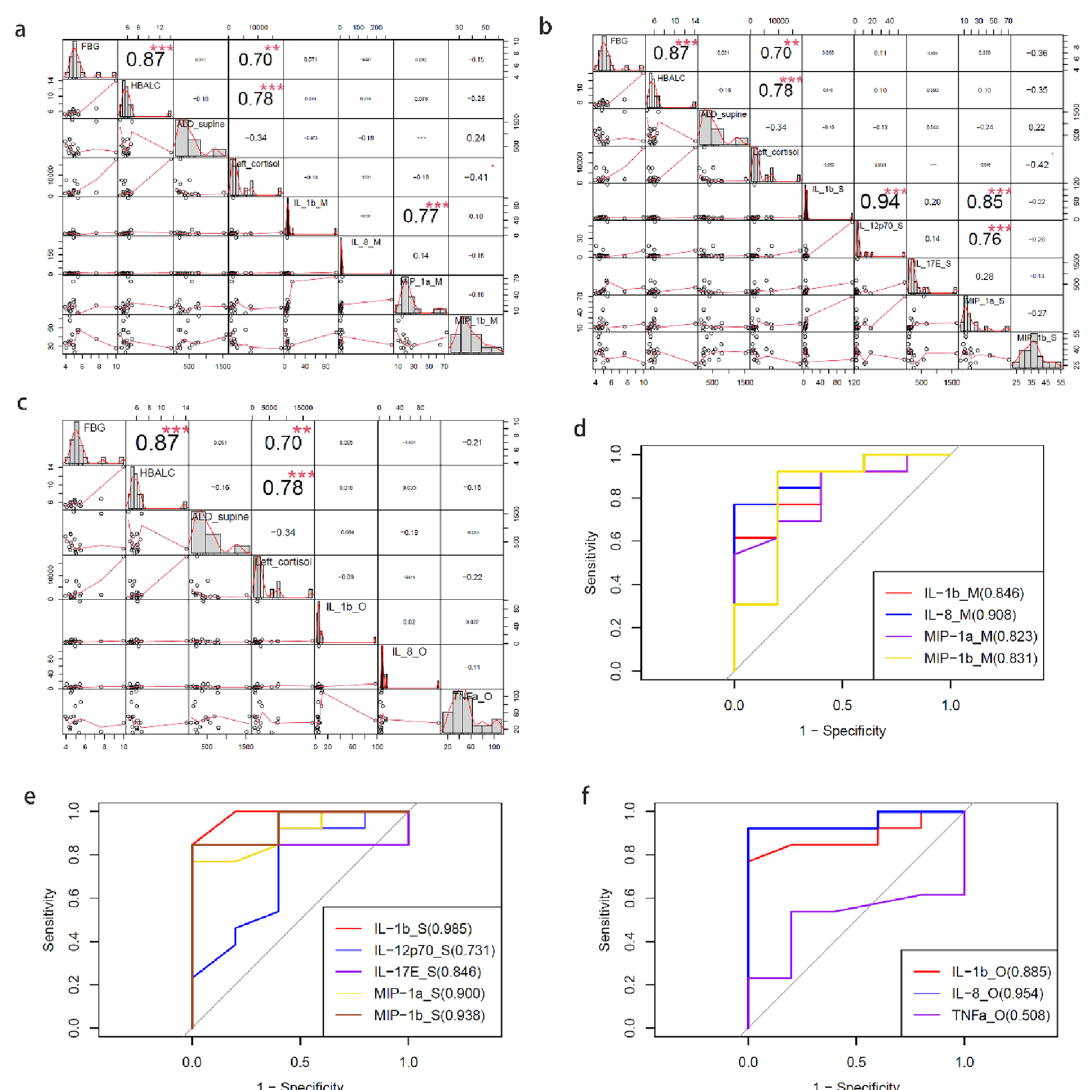
Figure 4. The correlation analysis between the clinical materials with the cytokines and the ROC curve of different histological type prediction. ( a ) The correlation analysis in the Middle group. ( b ) The correlation analysis in the Same group. ( c ) The correlation analysis in the Opposite group. ( d ) The ROC curve in the Middle group. ( e ) The ROC curve in the Same group. ( f ) The ROC curve in the Opposite